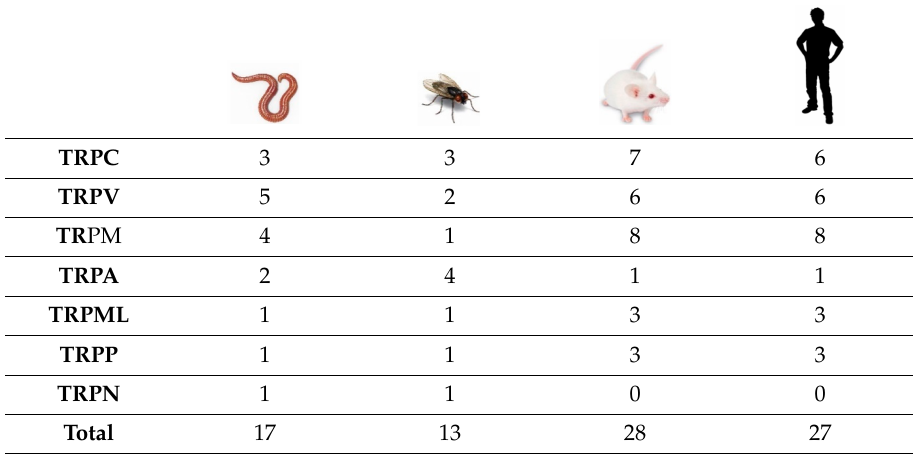
Table 1. Expression of transient receptor potential (TRP) channels in worms, flies, mice, and humans.